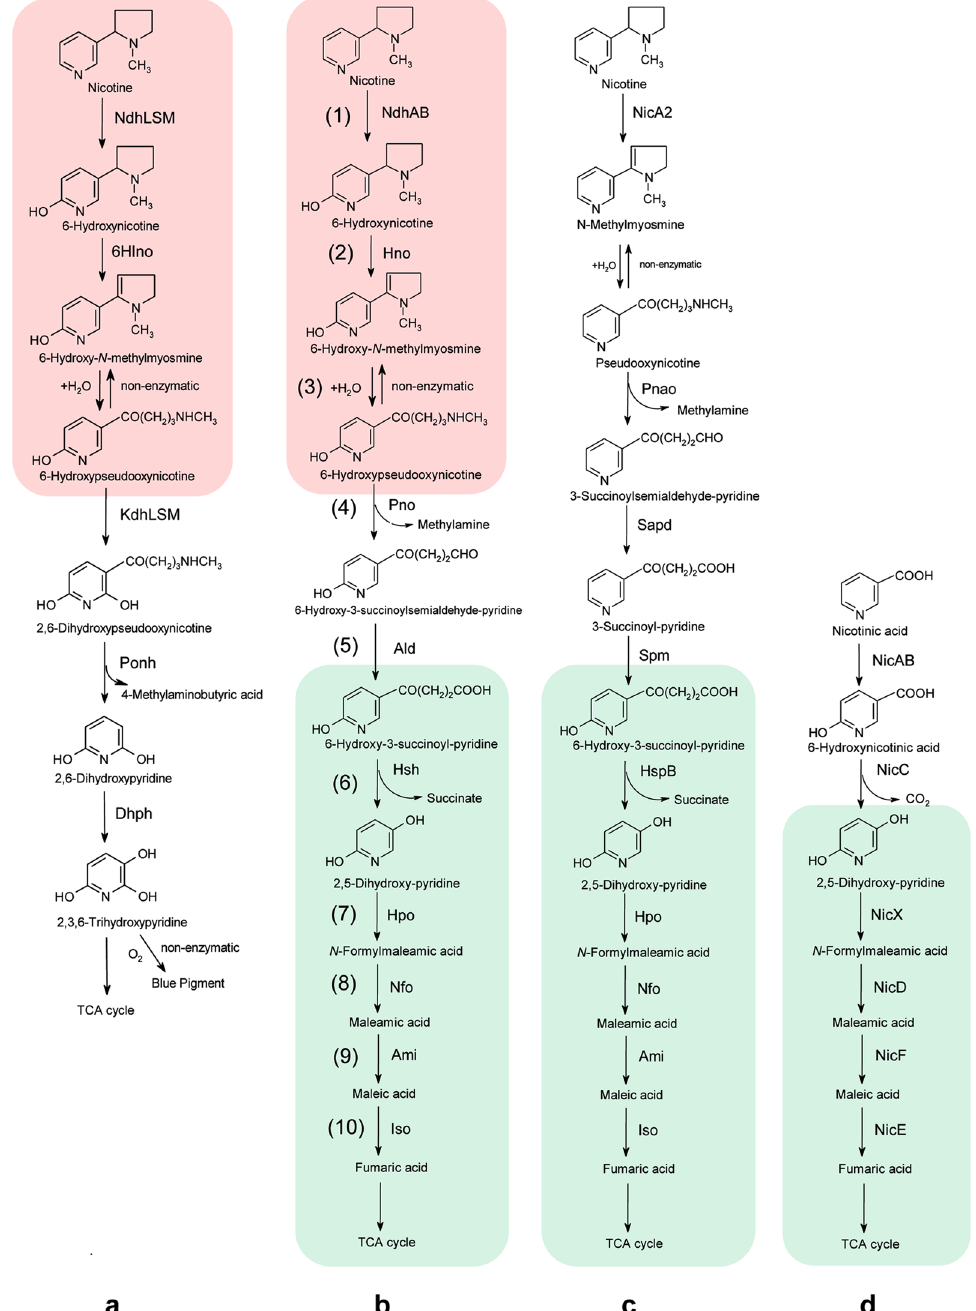
Figure 1. The pathways of nicotine and nicotinic acid degradation by some bacteria. ( a ) Pyridine pathway of nicotine degradation in Arthrobacter . Ndh, nicotine dehydrogenase; 6Hlno, 6-hydroxy-L- nicotine oxidase; Kdh, ketone dehydrogenase; Ponh, 2,6-dihydroxypseudooxynicotine hydrolase; Dhph, 2,6-dihydroxypyridine 3-hydroxylase; ( b ) A hybrid of pyridine and pyrrolidine pathways for nicotine degradation in A . tumefaciens S33 in this study. See Fig. 3 legend for enzyme abbreviations; ( c ) Pyrrolidine pathway of nicotine degradation in Pseudomonas . NicA, nicotine oxidoreductase; Pnao, pseudooxynicotine amidase; Sapd, 3-succinoylsemialdehyde-pyridne dehydrogenase; SpmABC, 3-succinoylpyridine monooxygenase; HspB, 6-hydroxy-3-succinoylpyridine hydroxylase; Hpo, 2,5-dihydroxypyridine dioxygenase; Nfo, N -formylmaleamate deformylase; Ami, maleamate amidohydrolase (amidase); Iso, maleate cis / trans - isomerase; ( d ) Nicotinic acid degradation pathway in Pseudomonas . NicAB, nicotinic acid hydroxylase; NicC, 6-hydroxynicotinate monooxygenase; NicX, 2,5-dihydroxypyridine dioxygenase; NicD, N -formylmaleamate deformylase; NicF, maleamate amidohydrolase (amidase); NicE, maleate cis / trans -isomerase. The same steps in the pyridine pathway and the hybrid pathway are shaded in red; the same steps in the hybrid pathway, the pyrrolidine pathway, and the nicotinic acid degradation pathway are shaded in